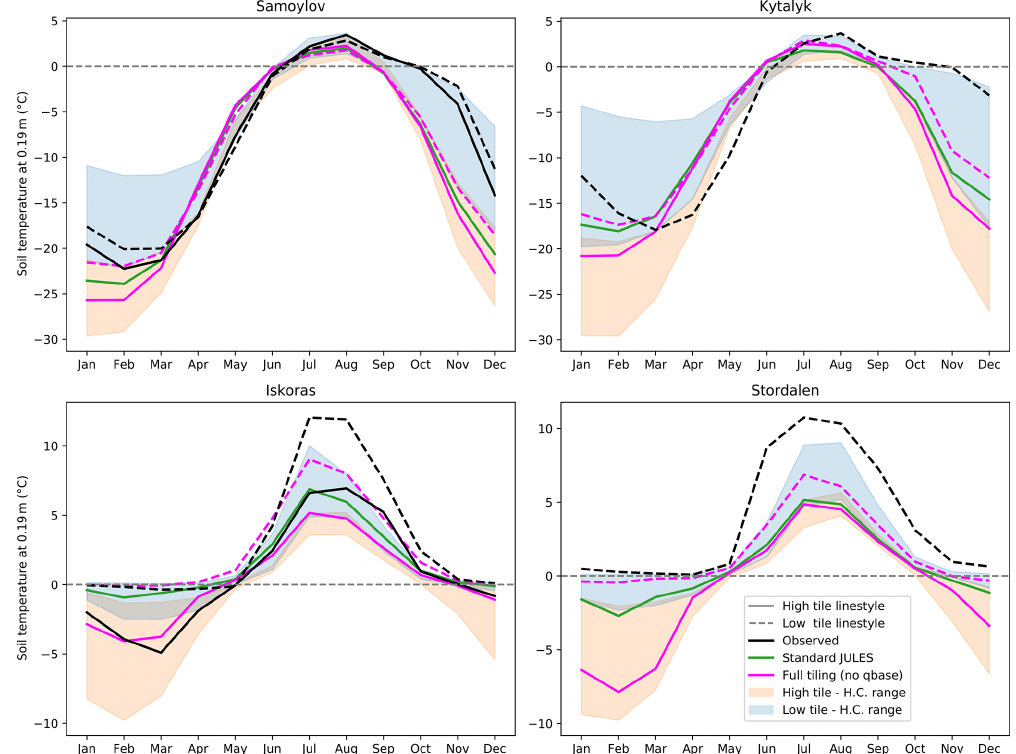
Figure 10. Climatologies (2000–2016) showing the seasonal heterogeneity in soil temperatures at 0.19m. Line styles show high and low tiles. Observations at this depth are not available for the polygon rim at Kytalyk and the palsa at Stordalen. “H.C.” indicates Latin hypercube sampling runs. The depths of the observations are as follows: for Samoylov, the rim was at 0.21m, and the centre was at 0.2m; for Kytalyk the rim was at 0.15m, and the centre was at 0.25m; for Iškoras, the palsa and mire were at 0.2m; and for Stordalen the mire was at 0.25m.